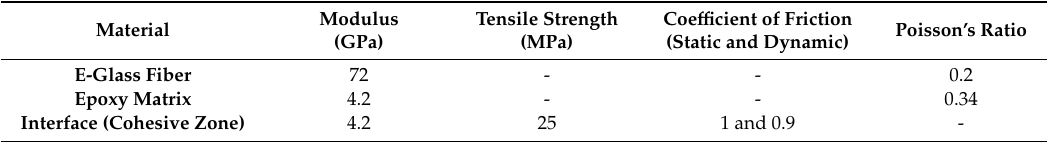
Table 2. Baseline material properties used in 2D axisymmetric